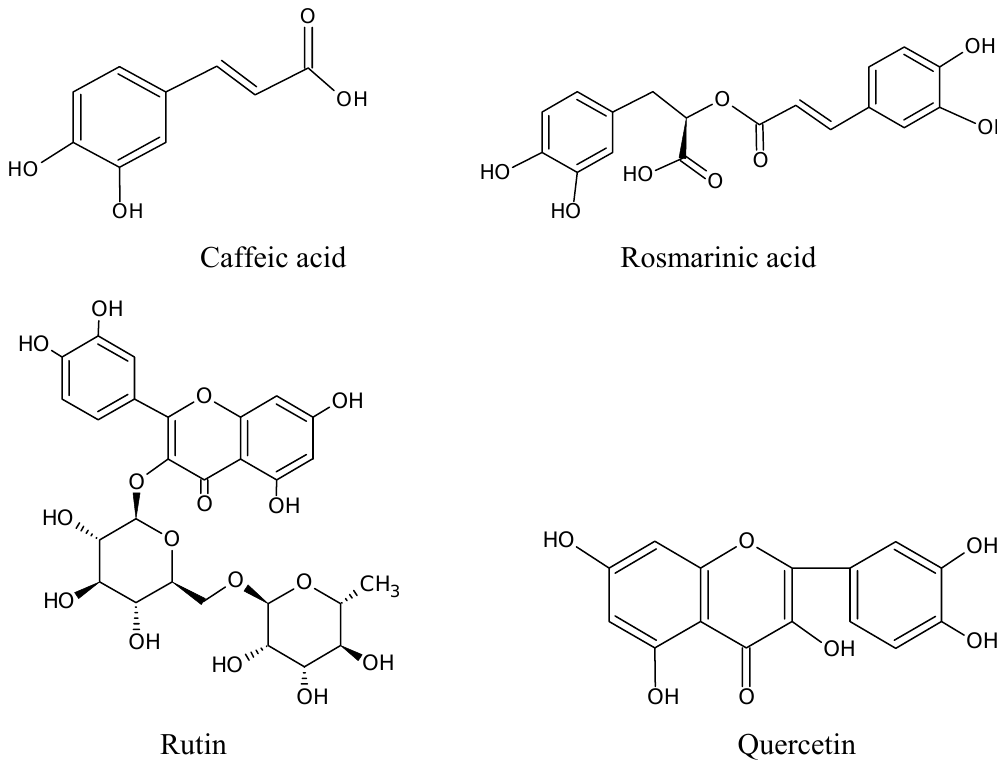
Figure 2. Chemical structures of major total phenol compounds in P-60.